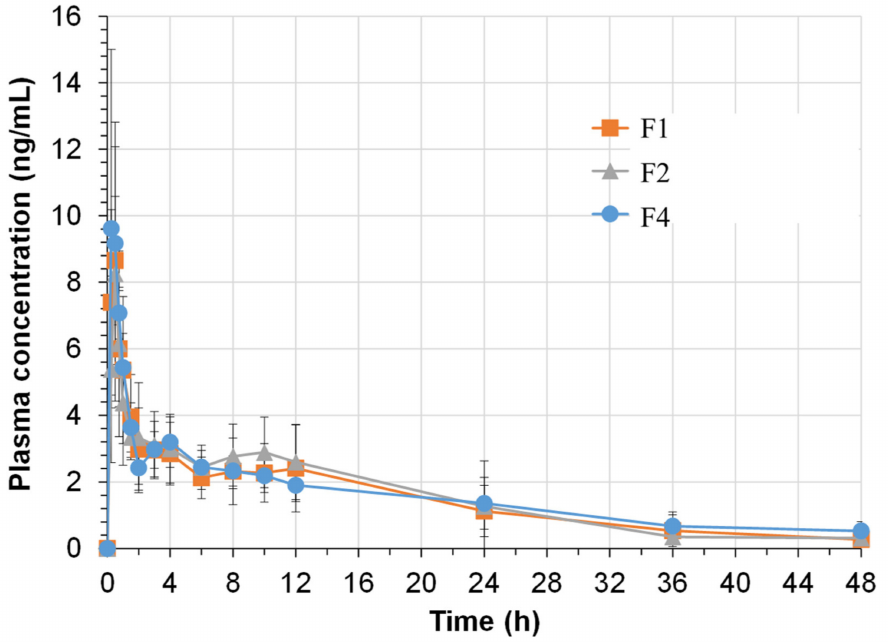
Figure 8. Plasma concentration-time profiles of JIN-001 following single oral administration of F1, F2 and F4 formulations (20 mg) to beagle dogs ( n =